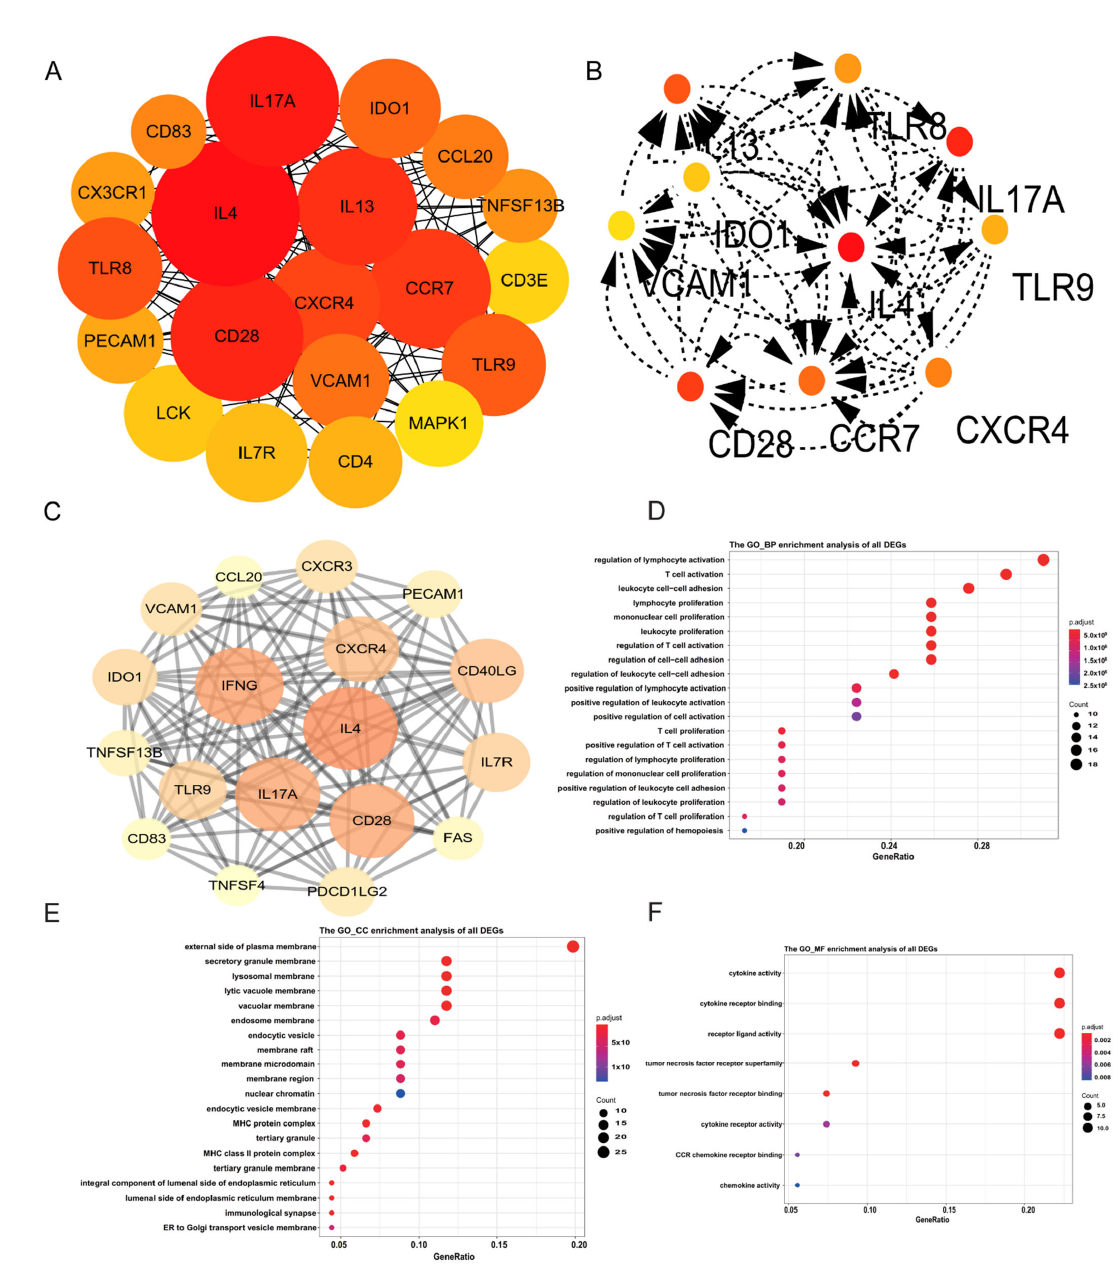
down-regulated genes.